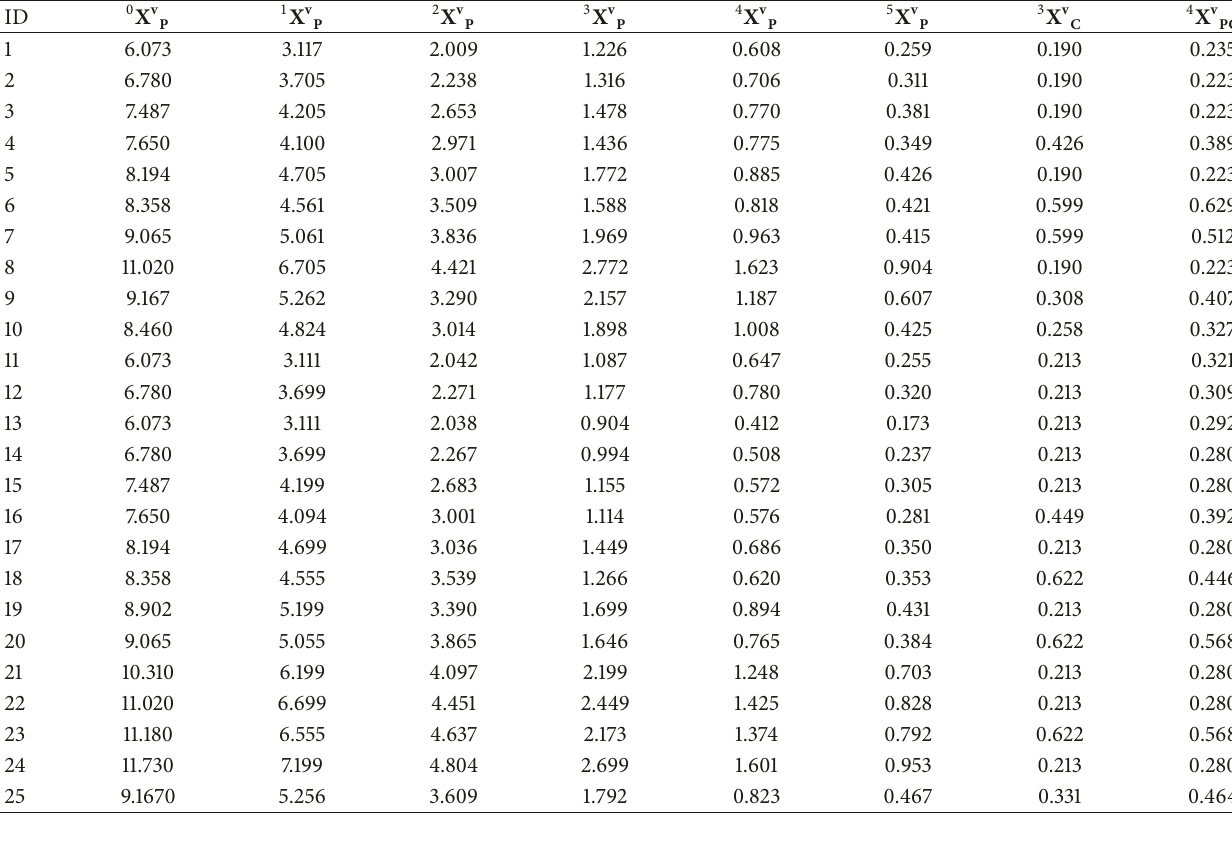
Table 4: Molecular connectivity indexes of hydroxyl benzoic group.